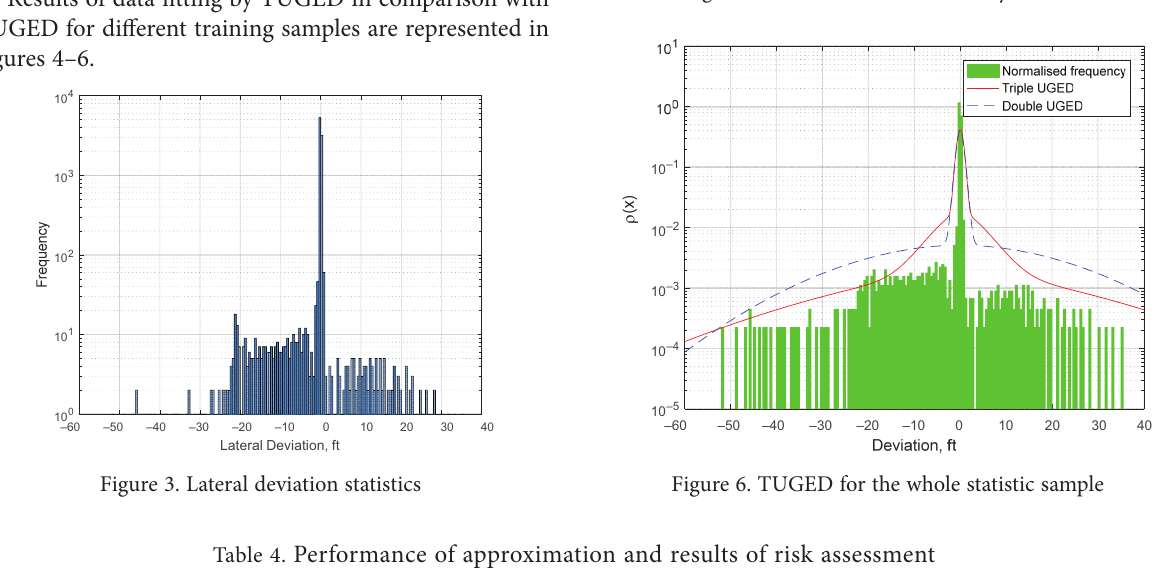
Figure 5. TUGED for 10/28 runway statistics